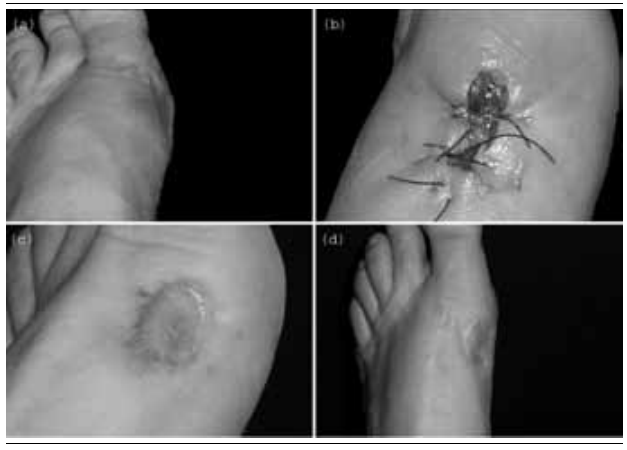
figurE 1 – Wound progression (a) erytematous nodule observed three months after contact with etiologic agent; (b) aspect of the lesion after surgical excision; (c) aspect of the affected area approximately four months after surgical procedure; (d) affected foot five years after infection.